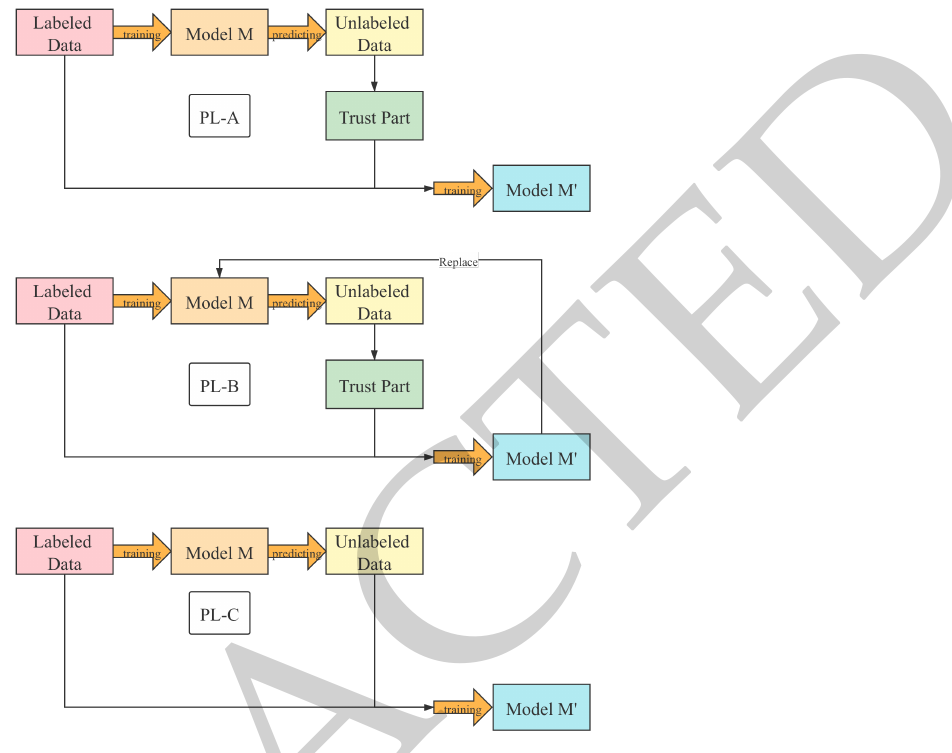
Figure 7. Flow chart of different pseudo-label models.